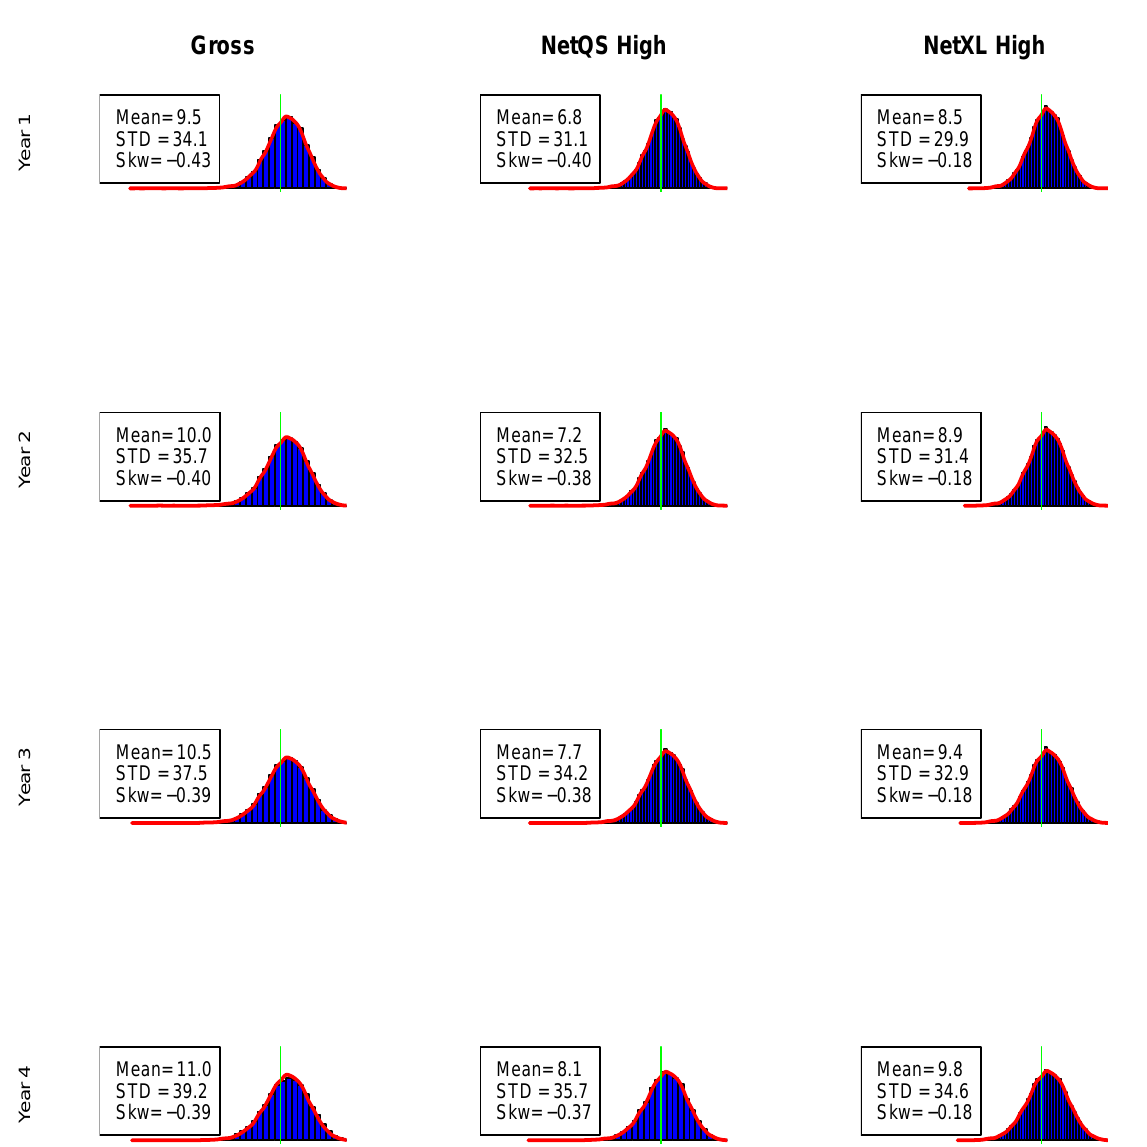
Figure 10. Simulated Gross and Net technical result distributions for Tau (green lines on value 0), during the following 4 years—Baseline Portfolio mix (the k -th row represents ˜ Y k